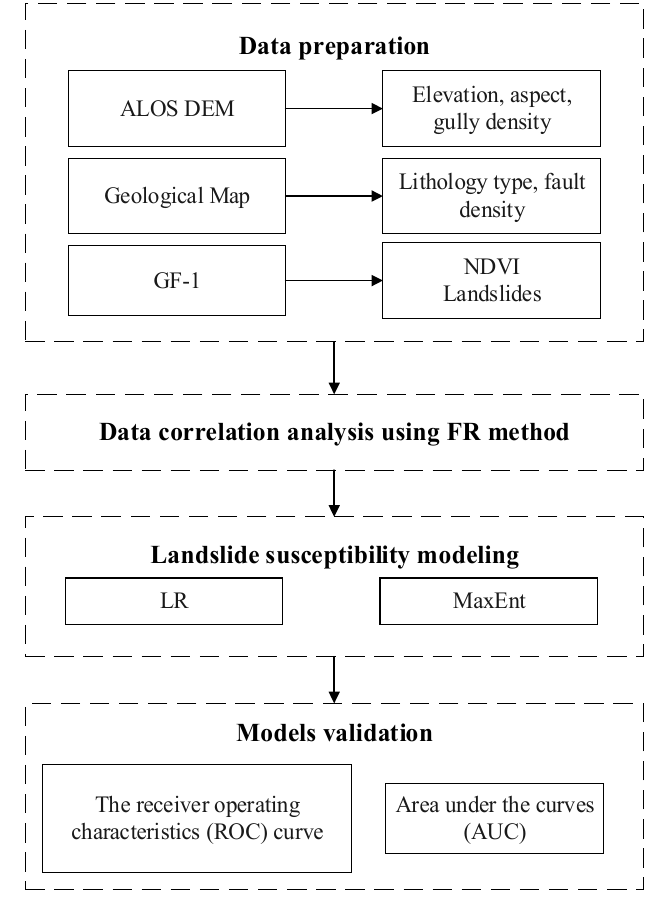
Figure 1. A diagram of the research steps of this study.